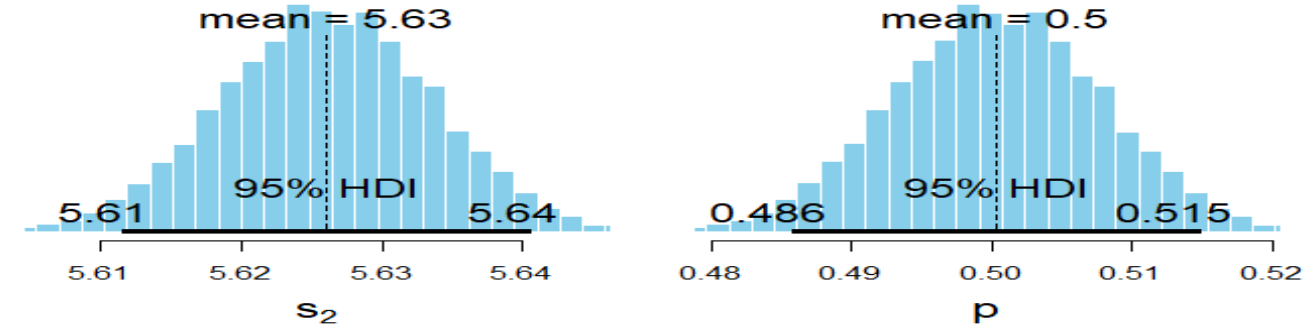
Figure 6. MCMC density and HDI intervals for results of Bayesian estimation of model for complete Bladder data for 9 parameters.